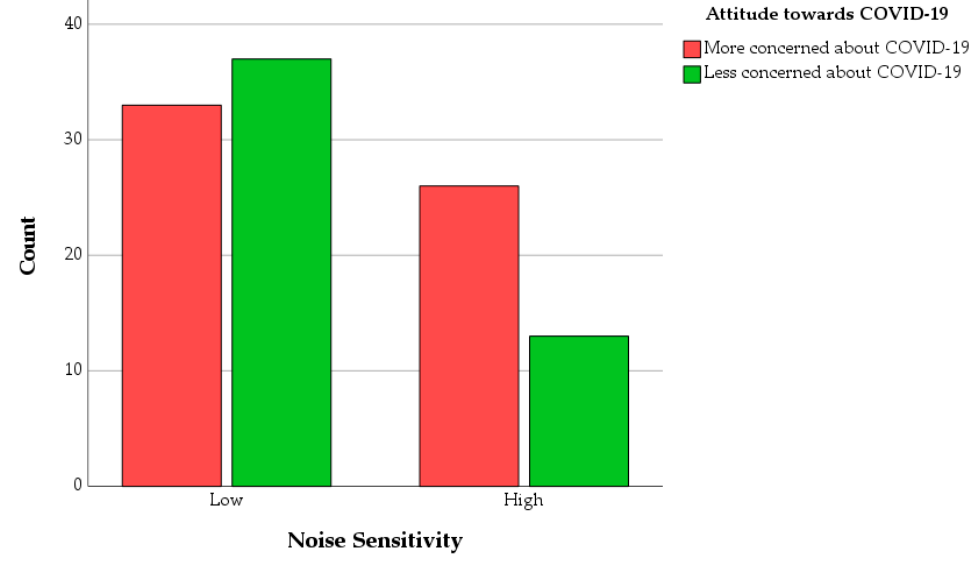
Figure 9. Bar charts of the number of Less and More concerned about COVID-19 participants (as per the ATC19 variable) as a function of Noise Sensitivity.